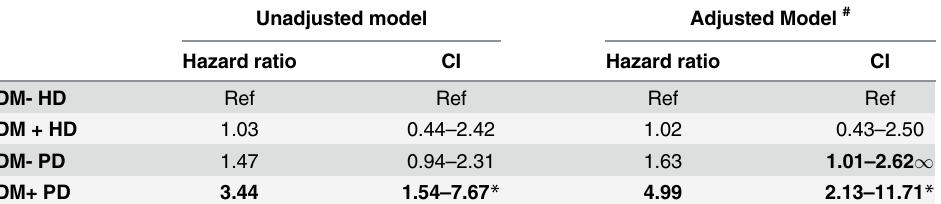
Table 5. Univariate and Multivariate relative risks of all-cause mortality according to Diabetes status and dialysis